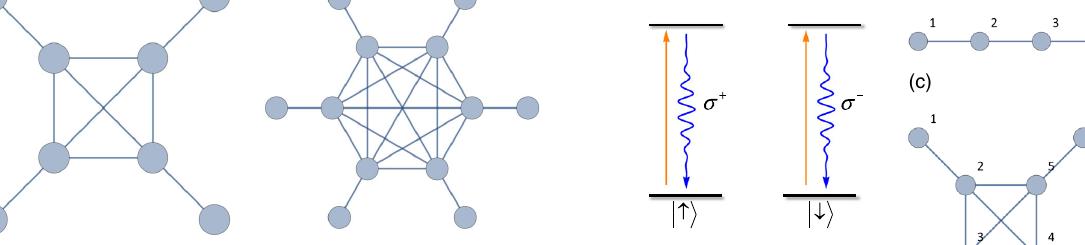
1. Graphical representation of N ¼ 4 and N ¼ 6 repeater states proposed in Ref. [16]. States consist of a complete subgraph of N core photons each connected to an additional photon forming N external